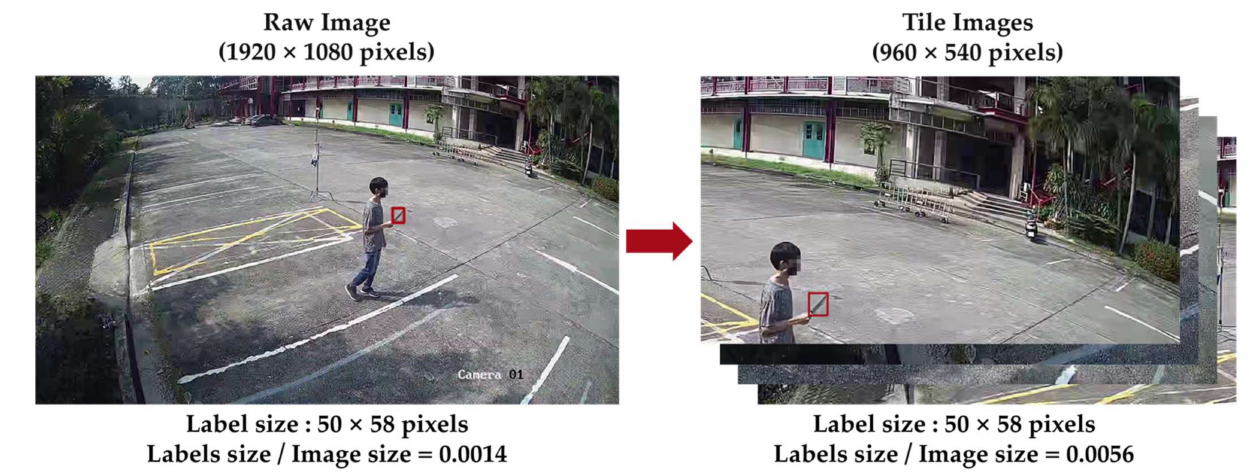
Figure 9. Example of raw image implementation on tiling